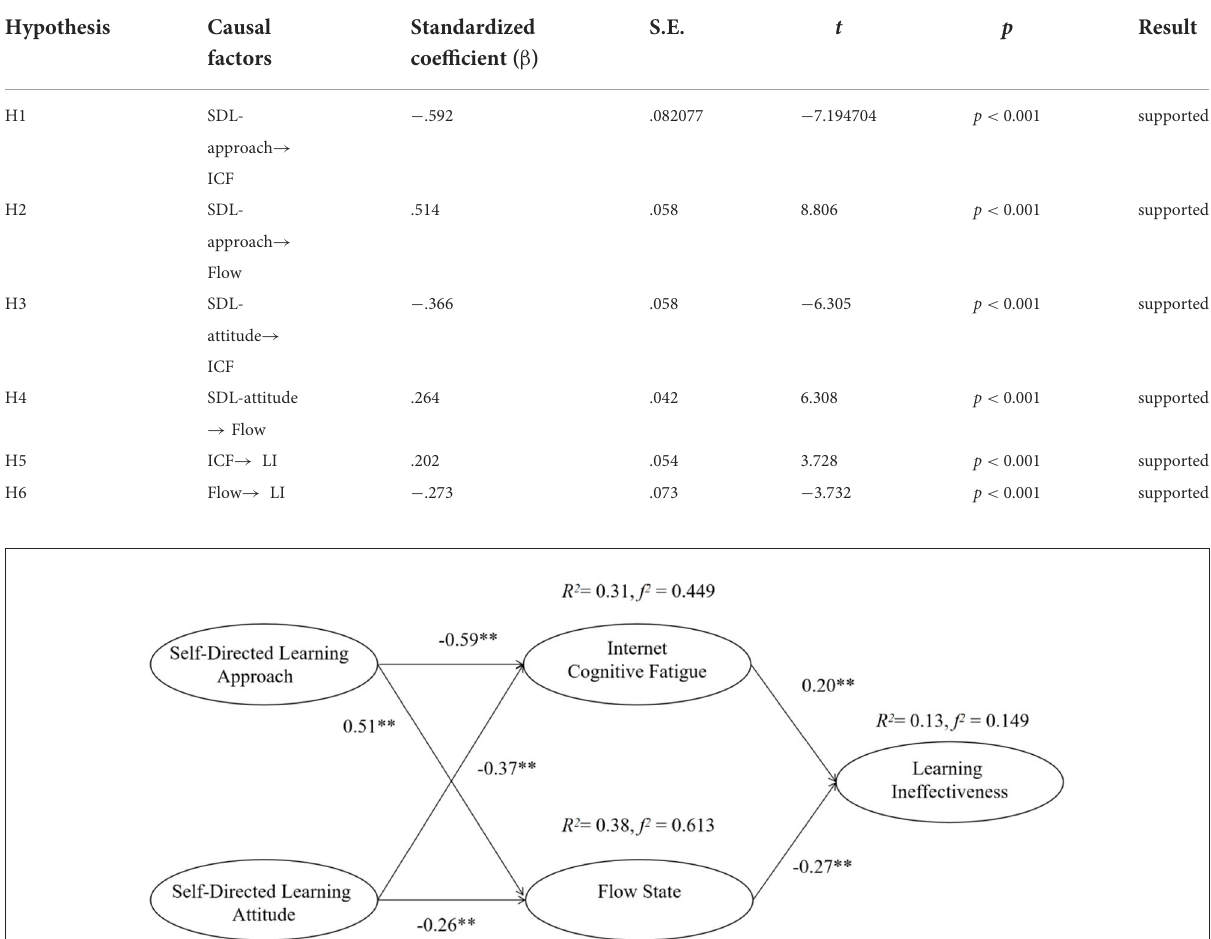
TABLE 4 Path coefficient analysis.